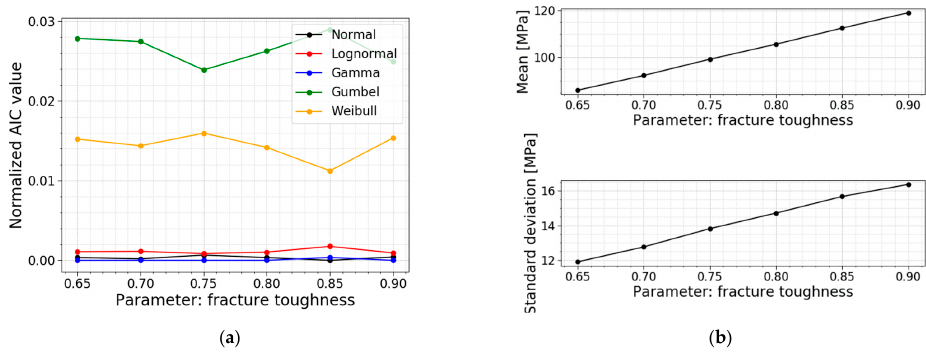
Figure 28. ( a ) AIC values and ( b ) the mean and st.dev. of the normal stress at failure for varying fracture toughness.